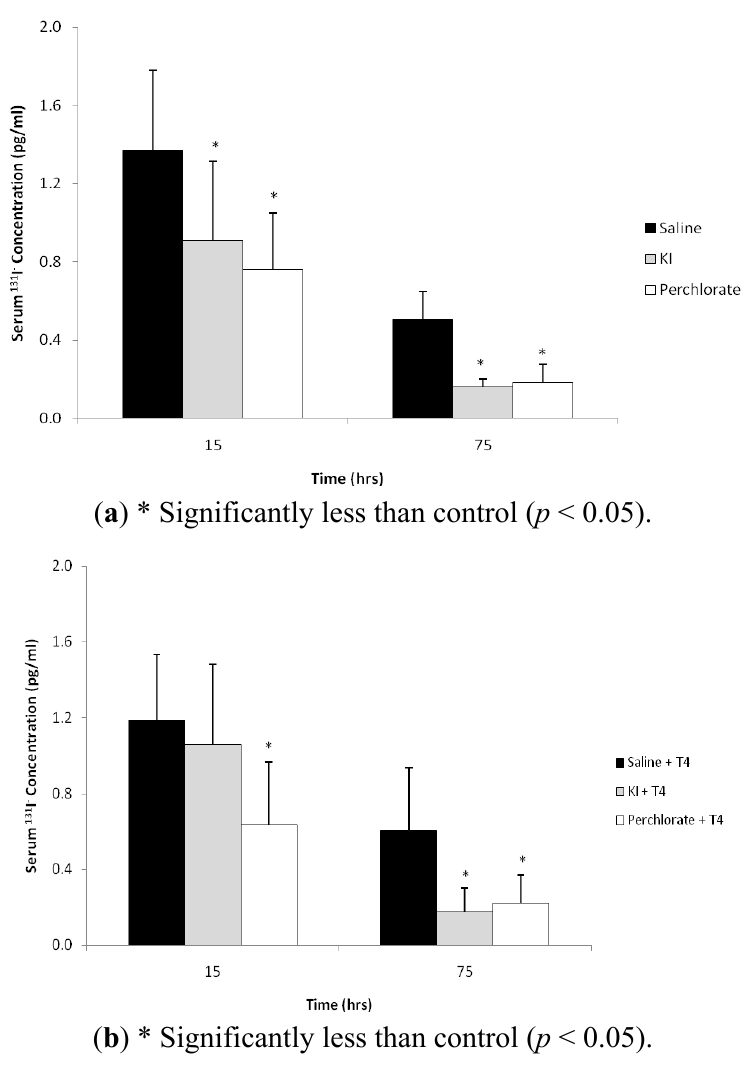
Figure 2. ( a ) 131 I − concentrations (pg/mL) in serum of Group 1 male rats collected via tail vein bleed at 15 and via cardiac puncture 75 hours after oral administration of 131 I − and 12 and 72 hours after oral administration of either saline, KI (30 mg/kg), or perchlorate (30 mg/kg) as described in Figure 1a. Data are means ± standard deviation (n = 12); ( b ) 131 I − concentrations (pg/mL) in serum of Group 2 male rats collected via tail vein bleed at +15 hours and via cardiac puncture at 75 hours after oral administration of 131 I − . Animals were dosed with 131 I − followed by saline, KI (30 mg/kg), or perchlorate (30 mg/kg) and as described in Figure 1b. Data are means ± standard deviation dosed with replacement T 4 (n =